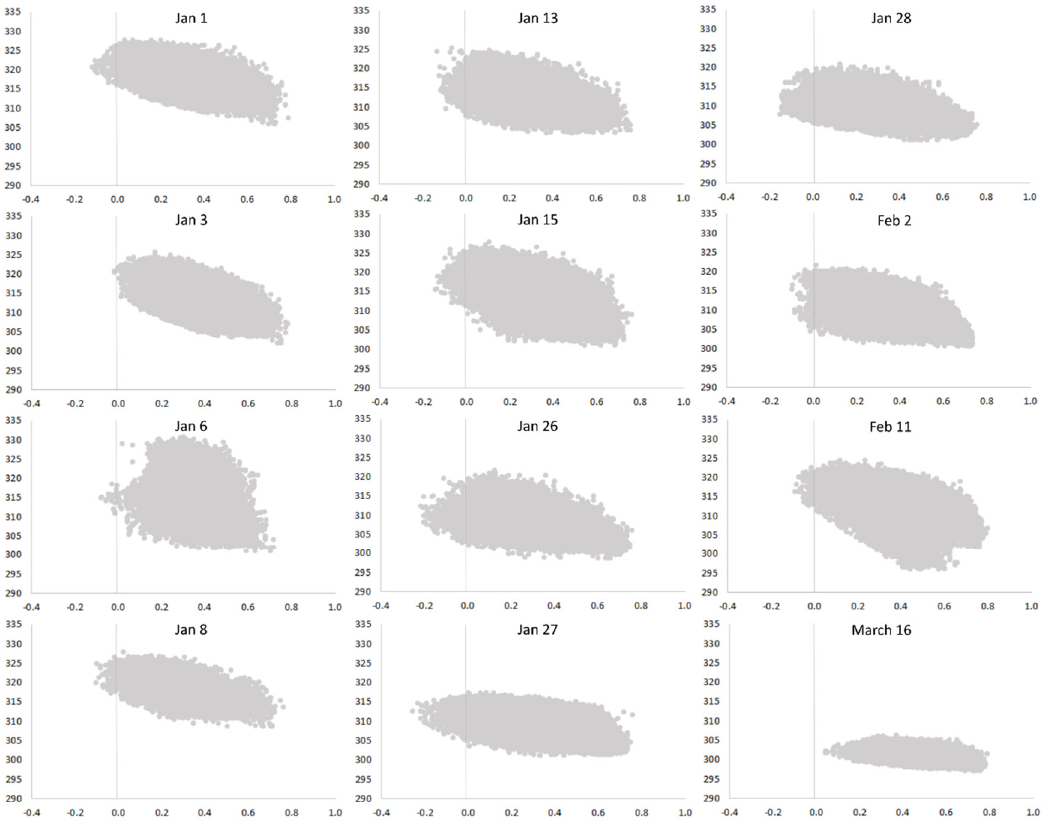
Figure 8. Examples of daily scatterplots of LST (K) ( y -axis) and NIR-SWIR index ( x -axis) from MODIS/Aqua measurements for vegetated surfaces in the study area during January and mid-March 2012.